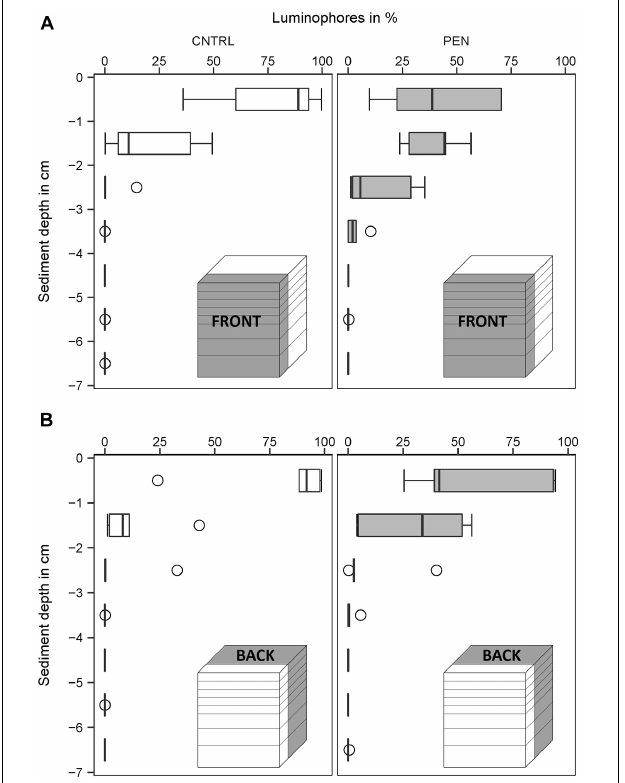
FIGURE 9 | Luminophore distribution (%) as a function of sediment depth (cm) in the mud sediment experiments with sand-like luminophores. (A) Front close to the plate for the CNTRL and PEN treatment. (B) Toward the back of the sediment for the CNTRL and PEN treatment. The box represents the interquartile range, the median is indicated by a line within the box. Whiskers indicate variability outside the interquartile range and circles indicate